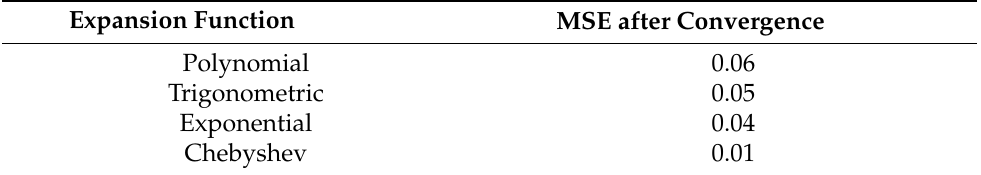
Table 4. a comparison of FLANN model convergence with four different base functions.